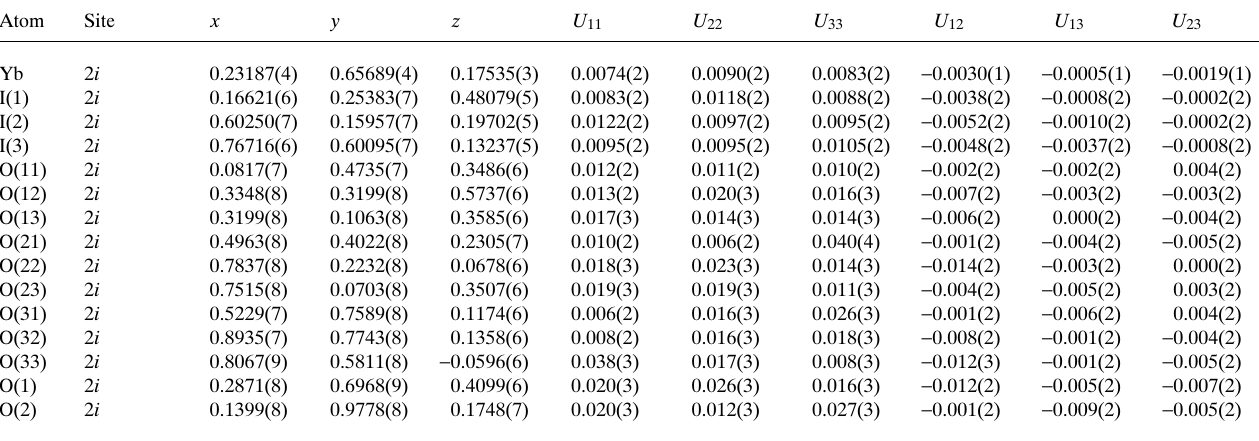
Table 2. Atomic coordinates and displacement parameters (in Å 2 ) .